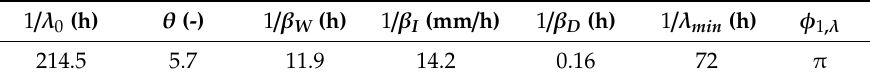
Table 2. Calibration results of the stationary version of NSRP model for Viterbo rain gauge.